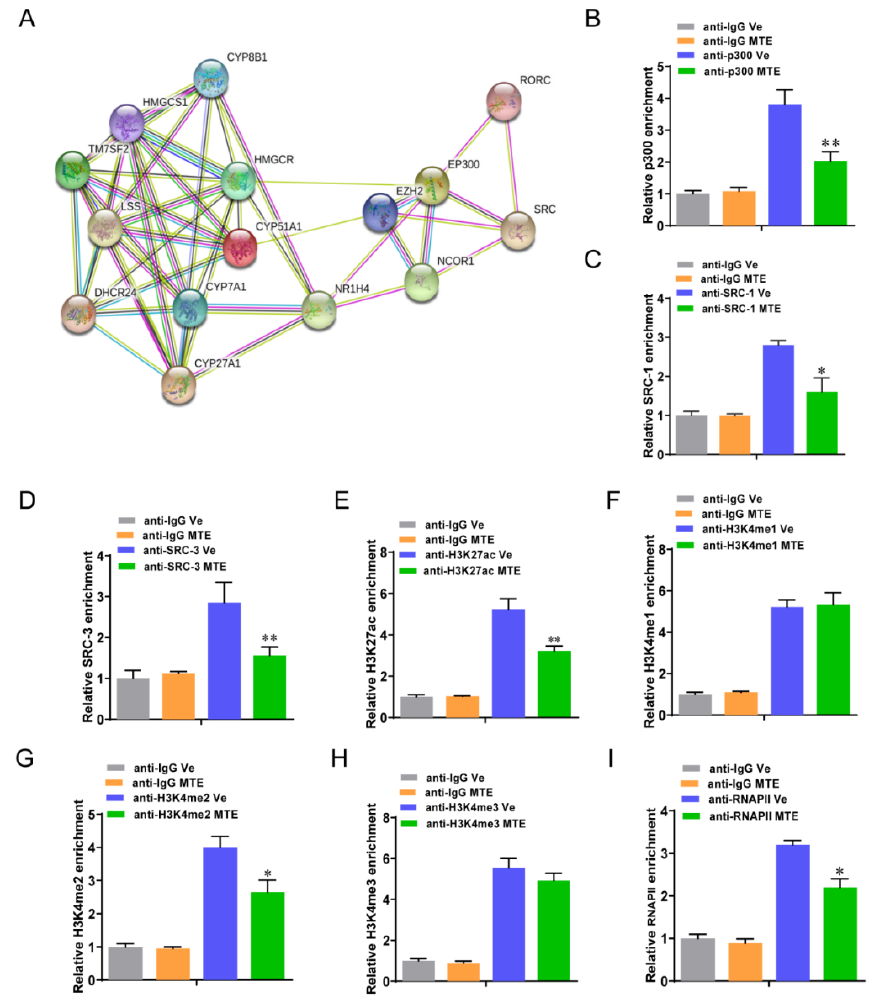
Figure 7. Mycotoxin exposure modulated ROR γ -associated histones modification. ( A ) STRING analysis of candidate co-factors of ROR γ transcriptional regulation. ( B – D ) ChIP-qPCR analysis of the relative enrichments of p300, SRC-1 and SRC-3 at the locus of HMGCS1 . ( E – I ) ChIP-qPCR analysis of the indicated enrichments of H3K27ac, H3K4me1/2/3 and RNA Polymerase II. Data were presented as means ± SD, * p < 0.05, ** p < 0.01.